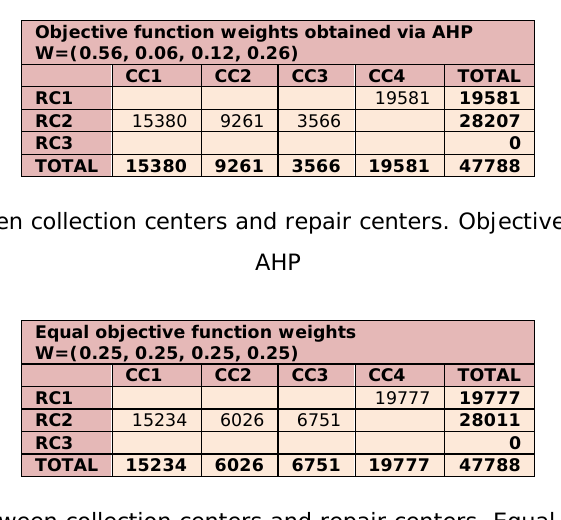
Table 8. Flows between collection centers and repair centers. Equal objective function